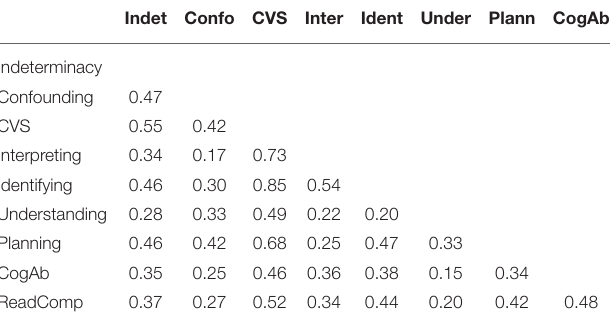
TABLE 2 | Intercorrelations of the main study